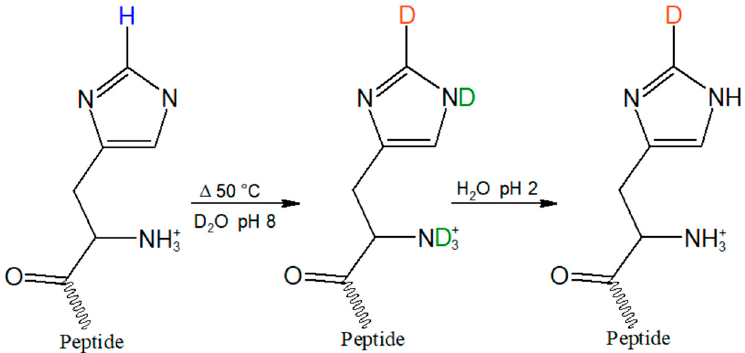
Figure 3. Incorporation of the C2 ‐ D probe (orange) on the histidine imidazole ring was achieved by heating the tripeptide in D 2 O for three days at 50 °C in D 2 O at pH 8. To back exchange readily exchangeable hydrogens on nitrogen and oxygen (green), the sample was then re ‐ dissolved in H 2 O, pH 2, and lyophilized.